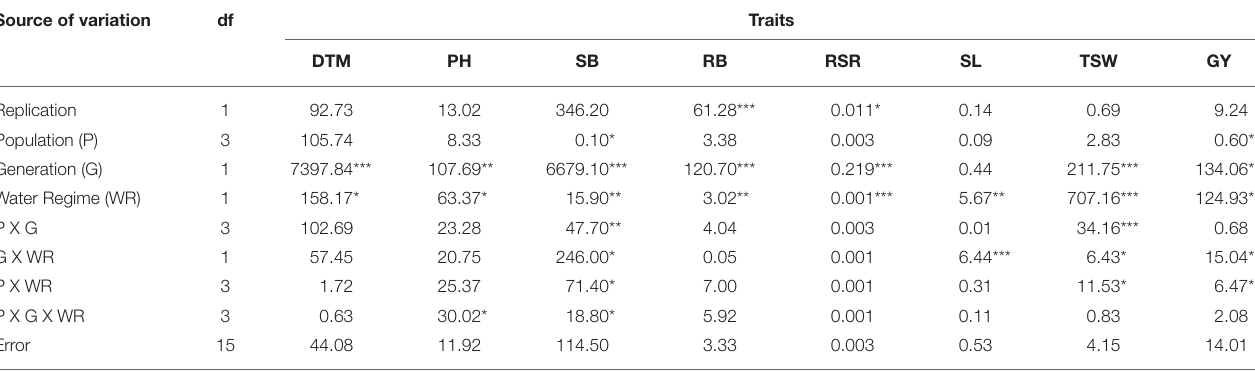
TABLE 4 | Mean squares and significant tests for traits measured in three EMS-treated and control populations of wheat under two water regimes at M 3 and M 4 generations. Source of variation df Traits